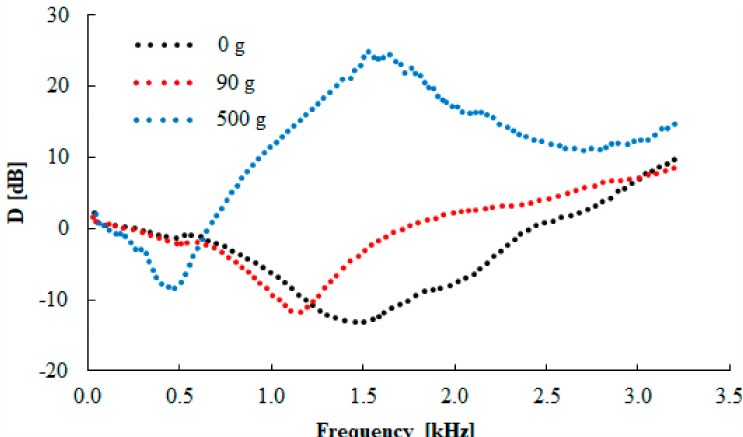
Figure 13. Frequency dependencies of the transfer damping function (D) for the tested N 330 rubber composite measuring t = 10 mm in thickness, loaded with di ff erent inertial masses.